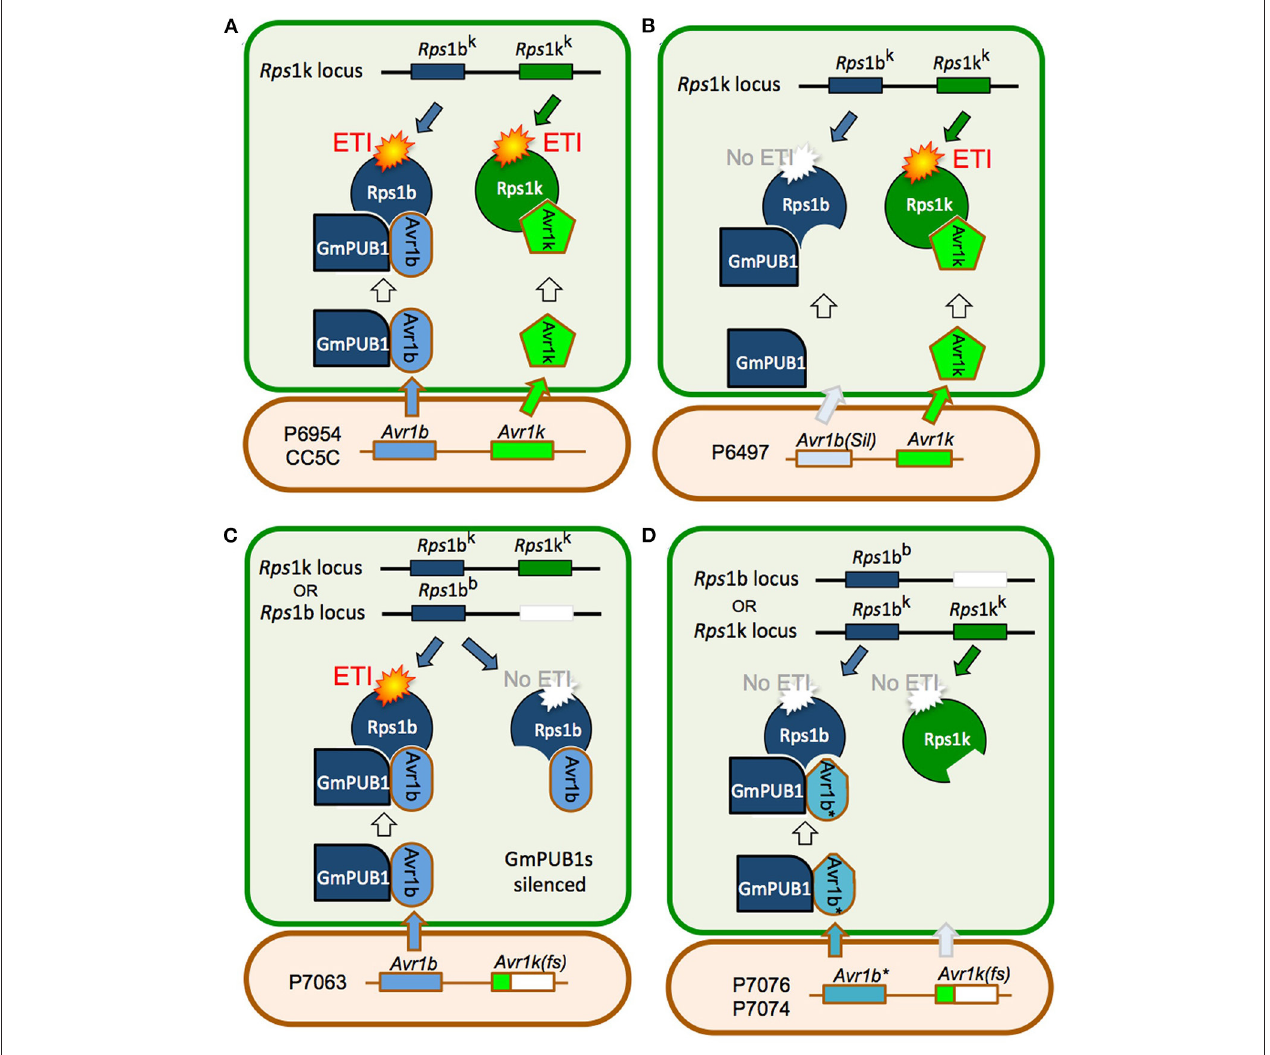
FIGURE 7 | Model for the role of GmPUB1 proteins in recognition of Avr1b by plants carrying Rps1 -b and Rps1 -k. (A) P. sojae isolates of race 1 such as P6954 (genotype I) and CC5C, produce two completely different RxLR effectors, Avr1b and Avr1k, encoded by closely linked genes. The Rps1 -k locus is proposed to encode two distinct proteins, Rps1-b k and Rps1-k k , responsible for recognition of Avr1b and Avr1k, respectively, triggering ETI. Recognition of Avr1b, but not Avr1k, requires the presence of GmPUB1 (either to form a physical complex as diagrammed, or to modify Avr1b). (B) When Avr1b is silenced, either experimentally or, naturally as in the case of P. sojae strain P6497 (race 2, genotype I), recognition by plants containing Rps1 -k still occurs ( via Rps1-k k ), but plants containing Rps1 -b cannot recognize the P. sojae strain (not diagrammed). (C) The soybean locus Rps1 -b is proposed to encode an Rps1-b b protein (functionally identical to Rps1-b k ) but no Rps1-k k protein. When the soybean GmPUB1 genes are silenced, Avr1b cannot be recognized by plants containing either Rps1 -b or Rps1 -k. If the P. sojae strain lacks Avr1k, as in the case of P7063 (race 6, genotype IV), silencing of GmPUB1 genes makes both Rps1 -b and Rps1 -k plants susceptible. (D) Some P. sojae strains such as P7076 (race 19, genotype II) or P7074 (race 17, genotype III) produce a variant Avr1b* protein that can bind to GmPUB1-1 but cannot be recognized either by plants carrying Rps1 -b or Rps1 -k. Since these strains also lack Avr1k , they can successfully infect plants carrying either Rps1 -b or Rps1 -k irrespective of the presence of GmPUB1